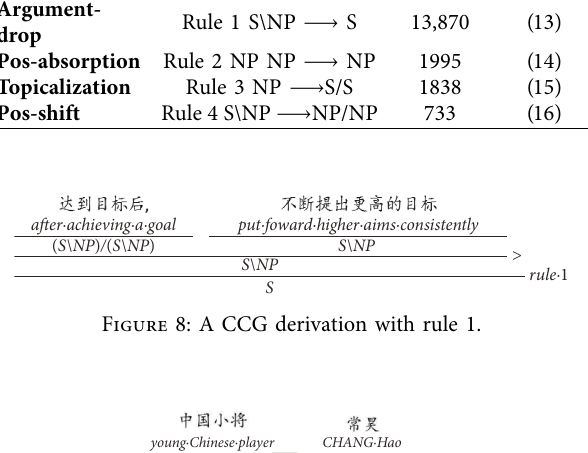
Figure 8: A CCG derivation with rule 1.